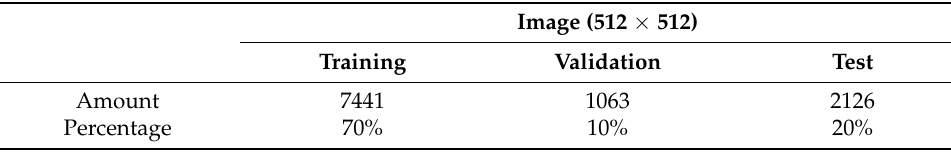
Table 1. Training, evaluation, and test set